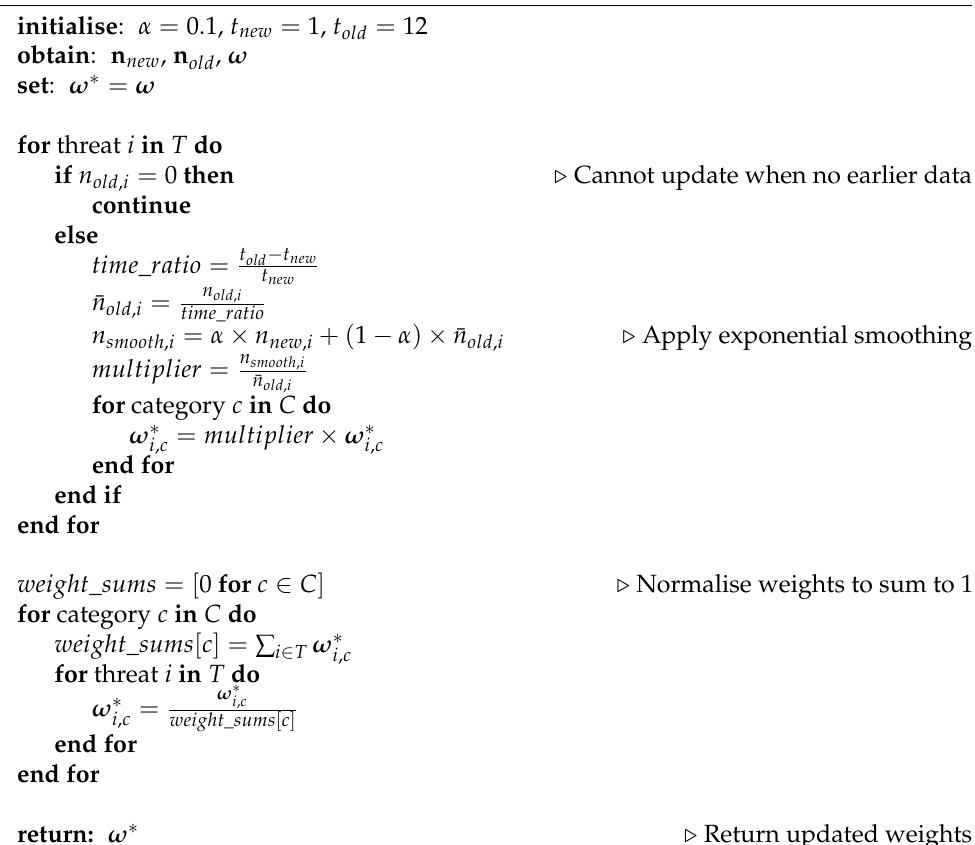
Algorithm 1 An example of an exponential smoothing algorithm that can be used to update threat